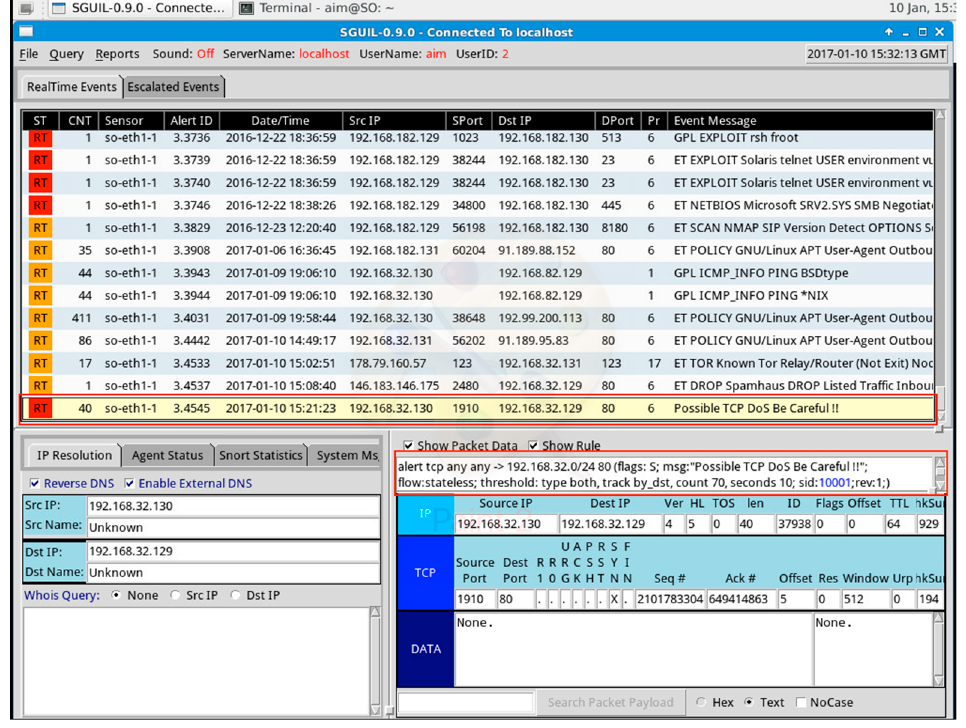
Figure 11. Sguil Console Output: DDoS Attack.